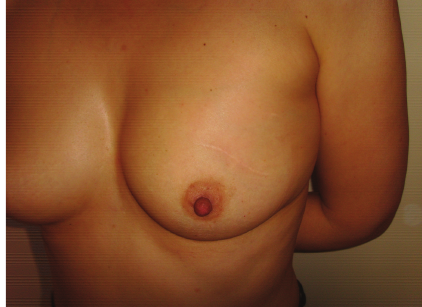
Figure 5: Excellent esthetic result 4 years after the